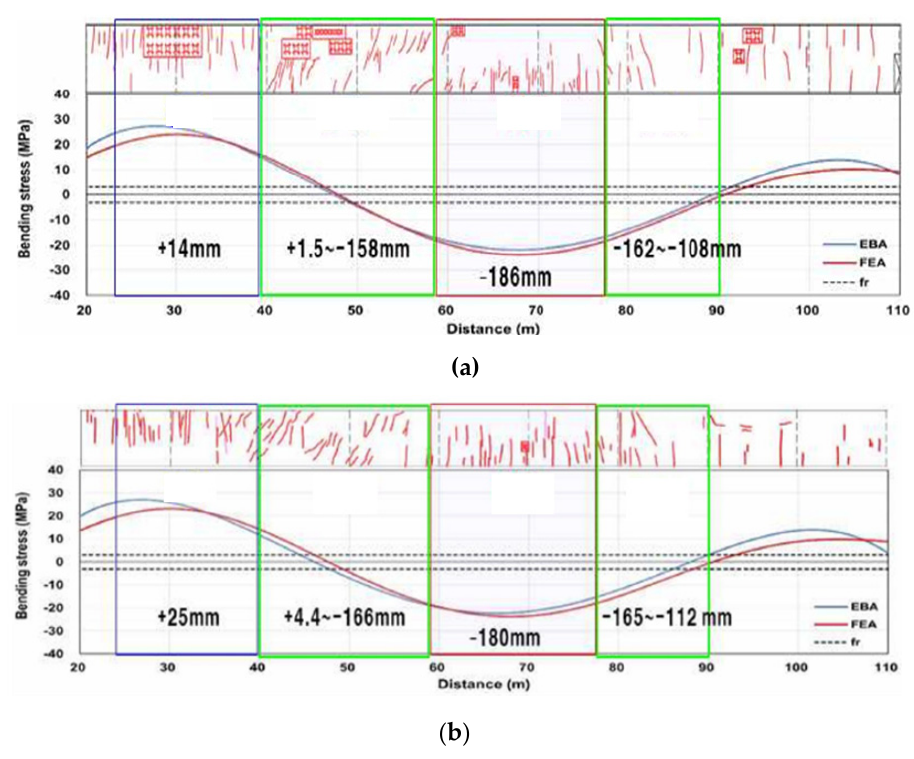
Figure 16. Comparison result of elastic beam and finite element analyses: ( a ) Cell 1; ( b ) Cell 2.